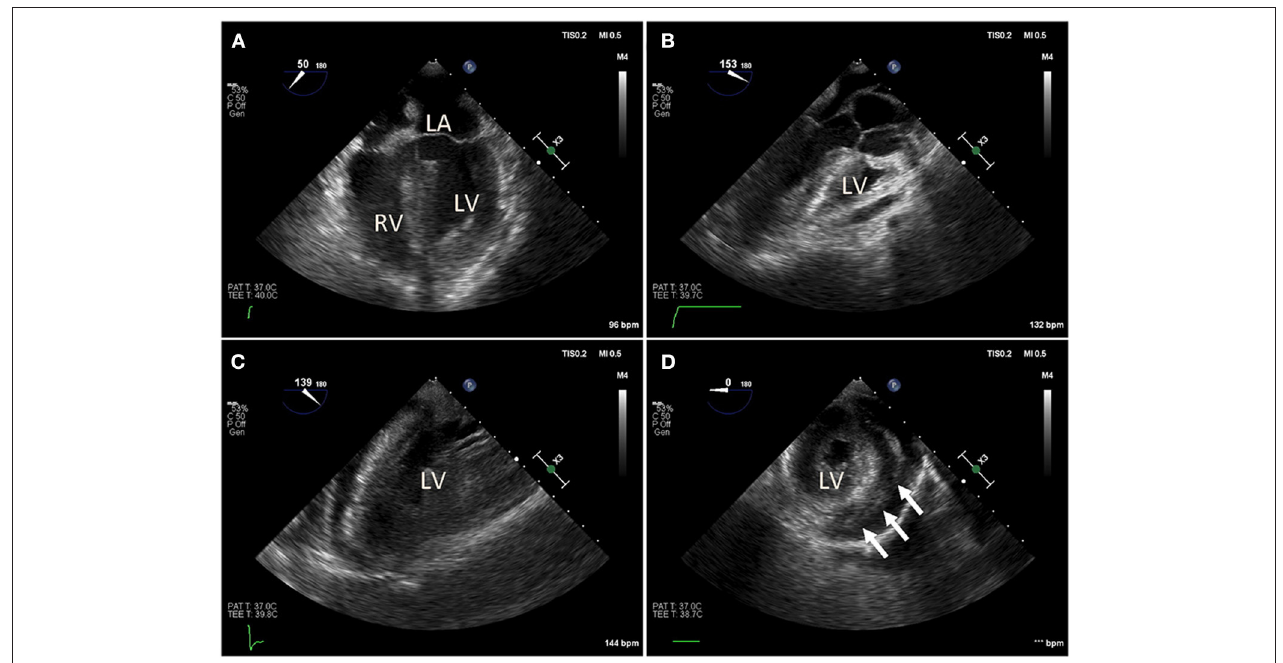
FIGURE 2 | Intraoperative trans-esophageal echocardiography (TEE) in a COVID-19 positive patient with myocarditis, acute pericardial effusion and cardiac tamponade. After bedside venous-arterial extracorporeal membrane oxygenation (VA-ECMO) cannulation was performed, the patient was taken to the operating room emergently for ventral cardiac window exposure and decompression of the pericardial effusion. (A) Preoperative mid-esophageal four chamber view demonstrated severely reduced global left ventricle (LV) function. (B,C) Similarly, mid-esophageal long axis view demonstrated severely reduced LV contraction. (D) Transgastric short axis view demonstrated under-filling of the LV. Patient was taken emergently to the operating room for cardiac window decompression of the pericardial effusion and a large pericardial effusion. An Impella device is seen in the LV.